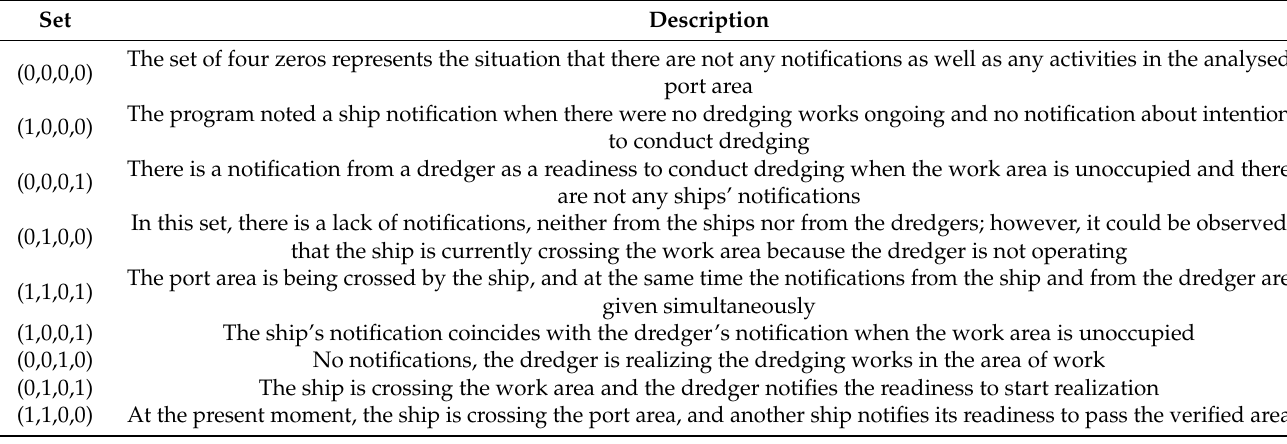
Table 3. Acceptable scenarios simulated in the program.